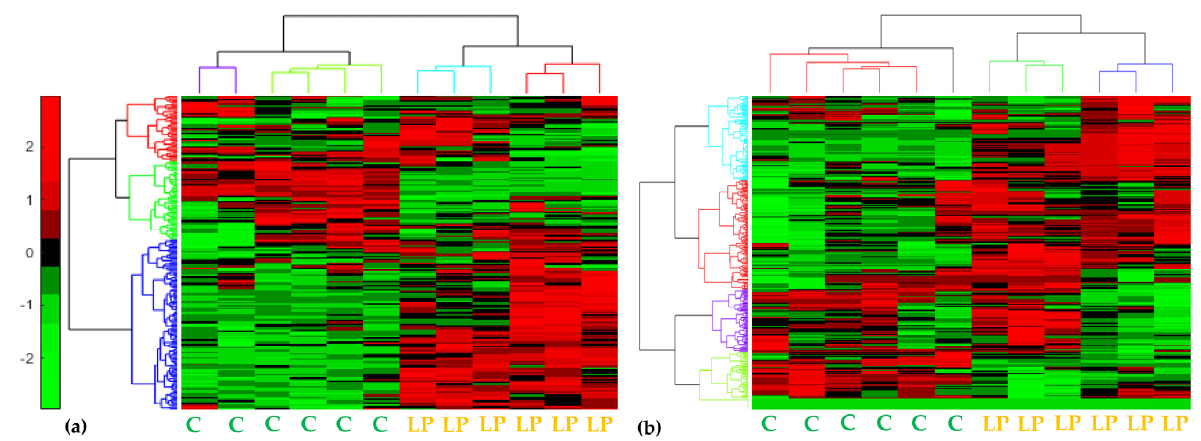
Figure 4. Two-dimensional cluster heat maps of the recorded ( a ) GC/EI/MS and ( b ) 1 H NMR metabolite pro fi les of Colletotrichum acutatum 17 days following treatments with olive tree endophytic Bacillus sp. lipopeptide extract. Hierarchical cluster analysis was performed by applying the linkage method of Ward. In total, 18 biological replications were performed per treatment, every three of which were pooled to provide a pooled sample (C; Untreated, LP; Lipopeptide-treated). PLS-DA, HCA, and heat maps con fi rmed the observed phenotypes, highlighting the di ff erences between the metabolic pro fi les of the untreated and LP-treated cultures (Fig- ures 3 and 4), providing solid evidence that the applied LP caused a substantial fl uctuation of the fungal metabolism. The metabolic di ff erences that are responsible for such fl uctua- tion were initially mined by performing multivariate analysis based on the values of scaled and centered regression coe ffi cients (Coe ff CS) (Figure 5) and the values of the var- iable in fl uence on projection (VIP) plots (Figure 6).